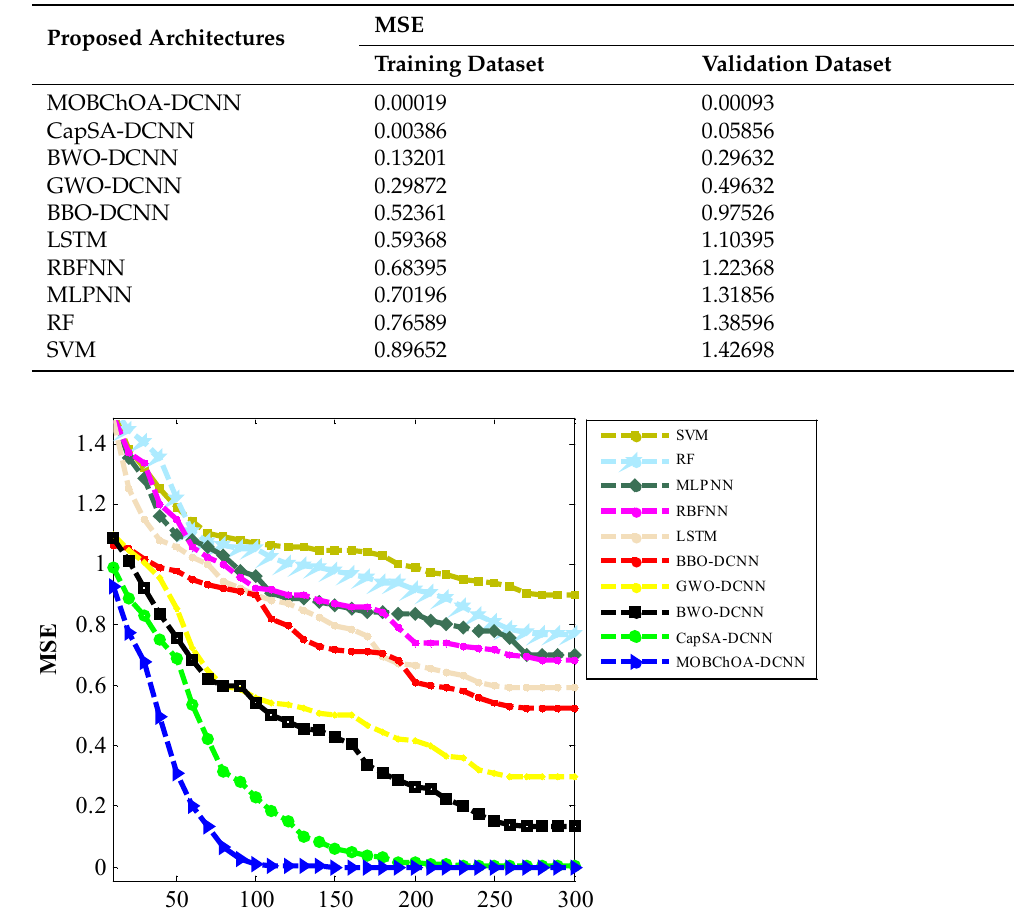
Table 7. Comparison of the algorithms according to MSE.